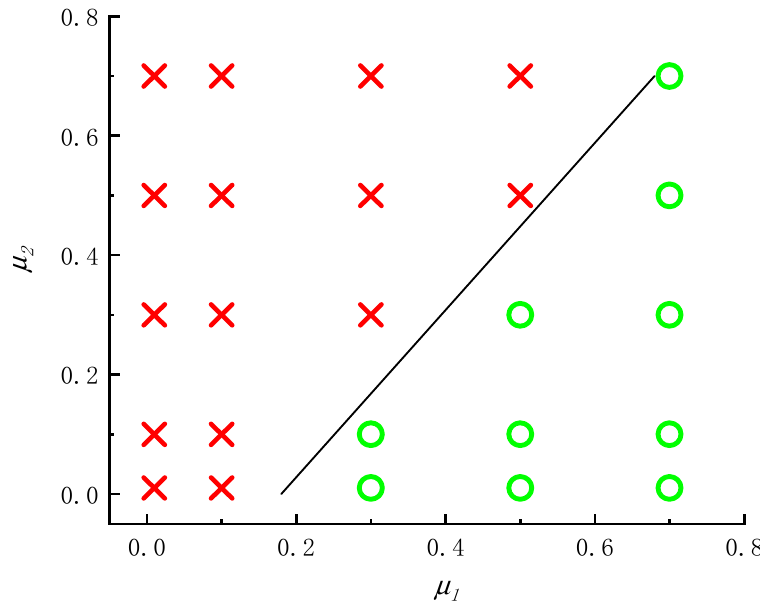
Figure 13. Effect of friction coefficient on forming limit.